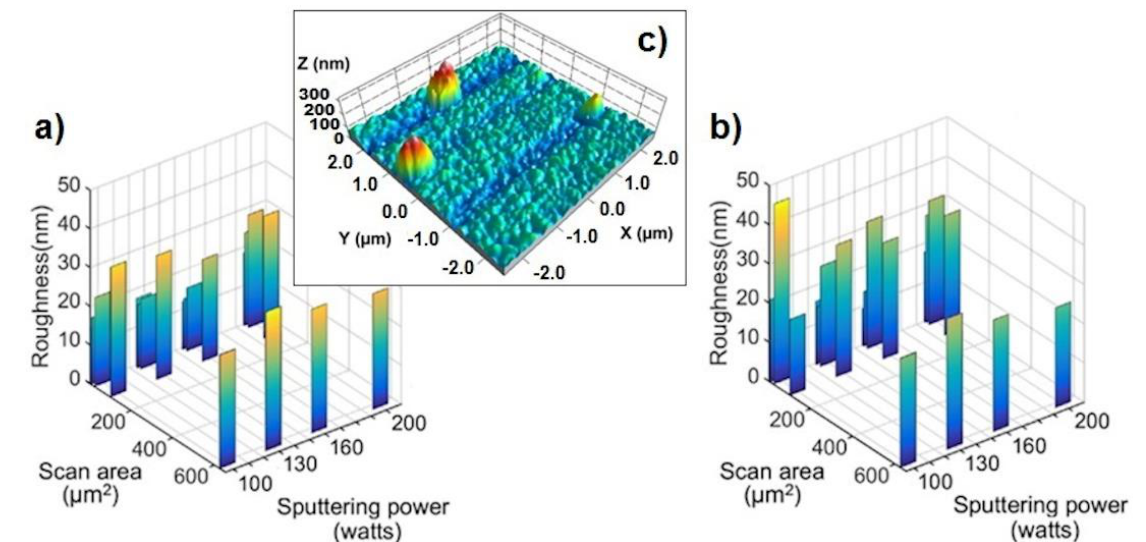
Figure 1. Bar charts of RMS in the aluminum films deposited on ( a ) glass, ( b ) silicon wafer, and ( c ) 3D AFM images of deposited at 200 W onto a silicon wafer for the scan areas of 25 µ m 2 .